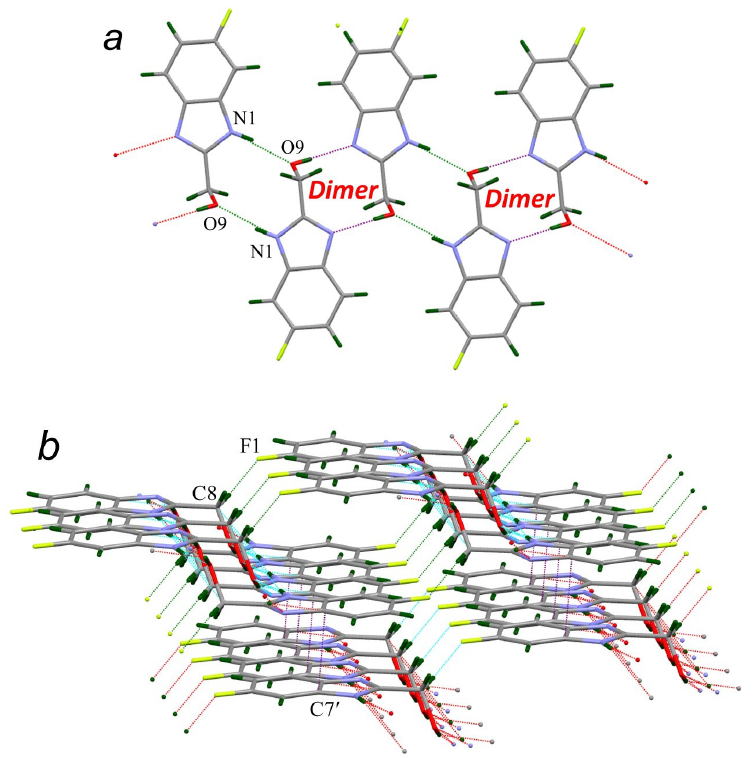
Figure 3. H‐bonded chains in the structure of 1b ( a ) and the binding of the chains via C–H…F and π–π interactions ( b ). π – π interactions ( b